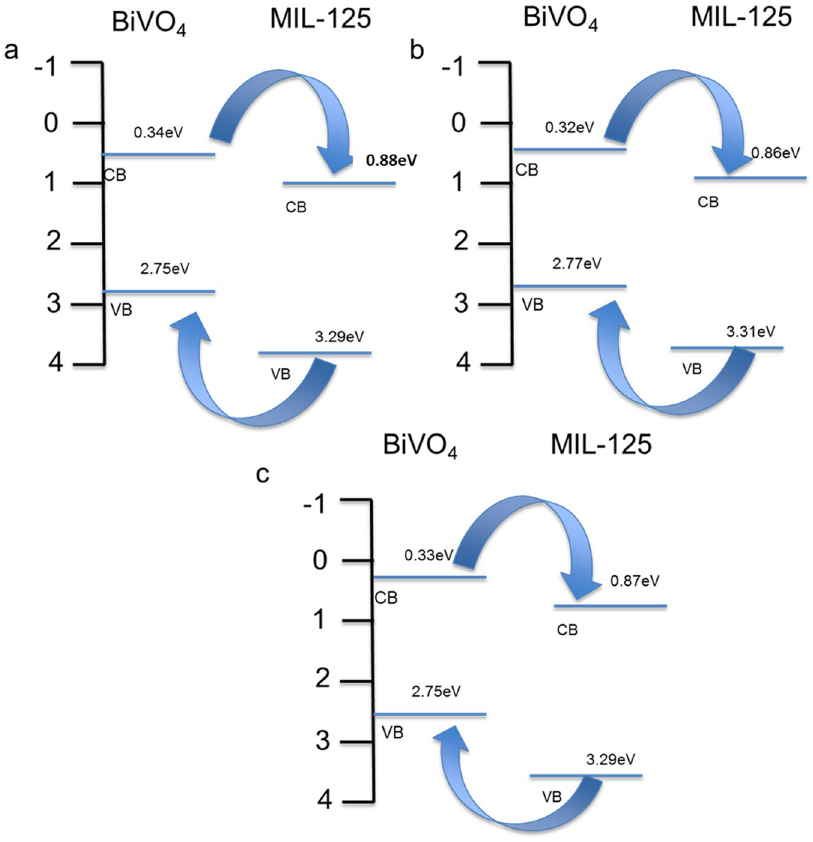
Figure 7. Band positions of the heterojunctions ( a ) 1–1 Bi:Ti, ( b ) 2–3 Bi:Ti and ( c ) 3-2